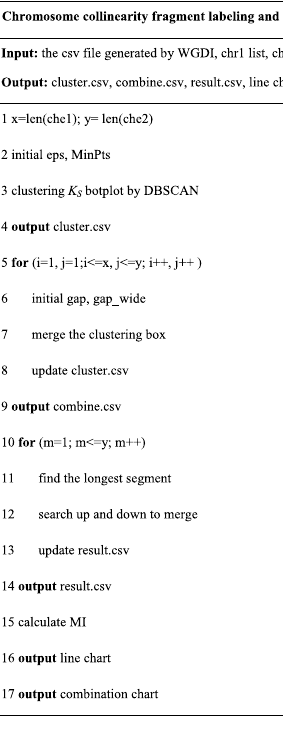
Algorithm 1. Chromosome collinearity fragment labeling and